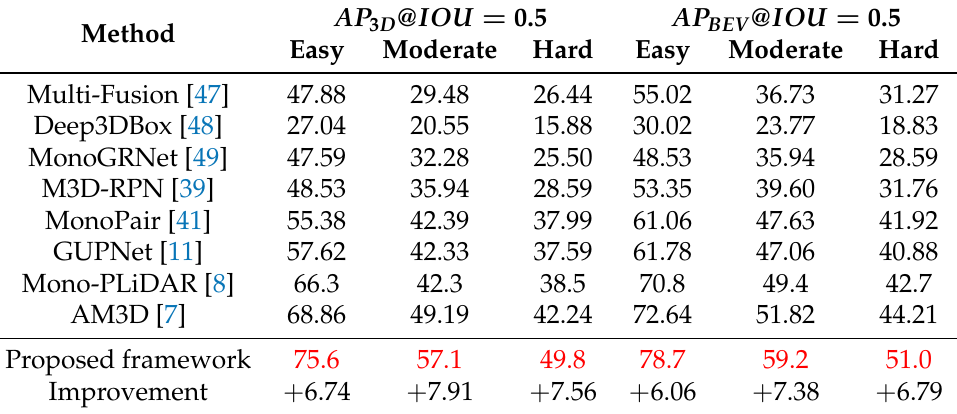
Table 3. Performance of 3D detection of the "car" category under AP @ IOU = 0.5 of the